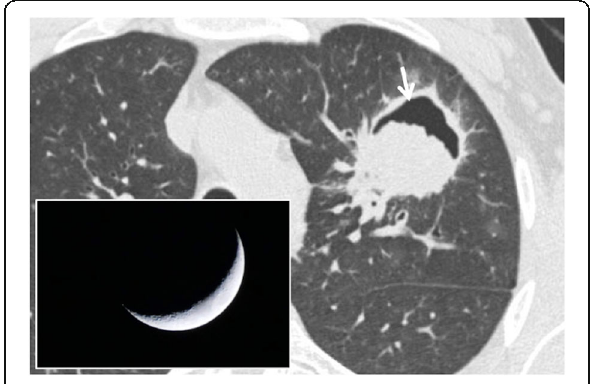
Fig. 2 Air crescent sign. CT scan of a patient with pulmonary aspergillosis showing a necrotic and cavitated lesion (white arrow) in left upper lobe. The air filling the cavitation looks like the shadow of a crescent moon — which is demonstrated in the embedded